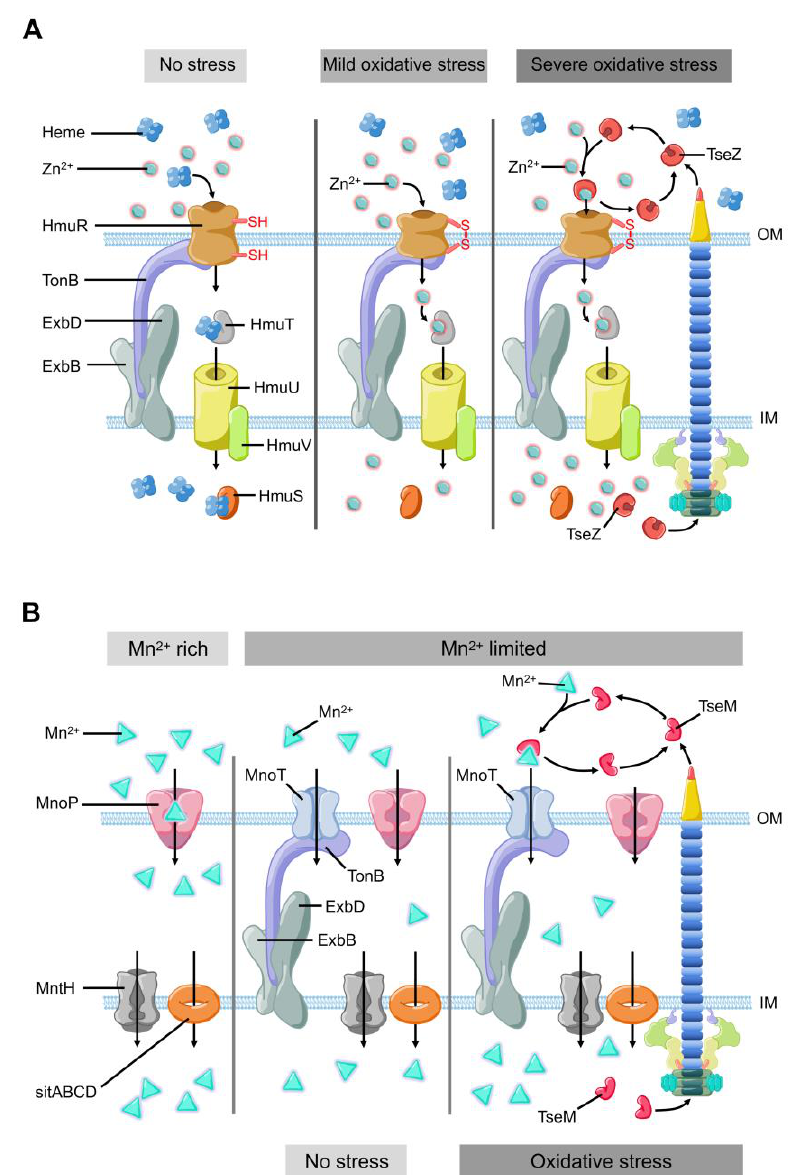
Figure 2. The model of T6SS-mediated stress response to environmental pressure. ( A ) B. thailandensis T6SS effector TseZ as a proteinaceous zincophore interacts with heme transporter HmuR to acquire zinc, which facilitates Zn 2+ transportation to resist oxidative stress. HmuR forms intramolecular disulfide bond to transport zinc instead of heme under oxidative stress. ( B ) B. thailandensis T6SS effector TseM transports Mn 2+ to resist oxidative stress with the help of outer membrane transporter MnoT. TseM is secreted into the extracellular milieu to scavenging Mn 2+ and deliver it to MnoT when bacteria encounter oxidative stress.